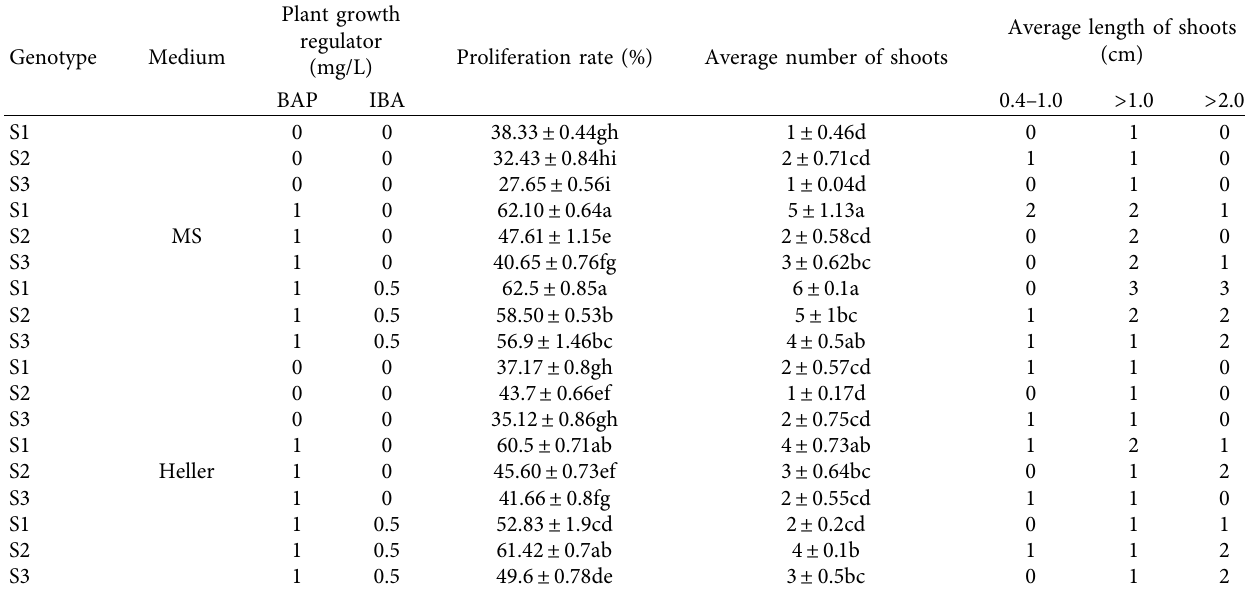
Table 2: Proliferation rate, average number, and length of shoots of “Beldi” almond ecotype on MS and Heller media added with 1mg/L of BAP or IBA.